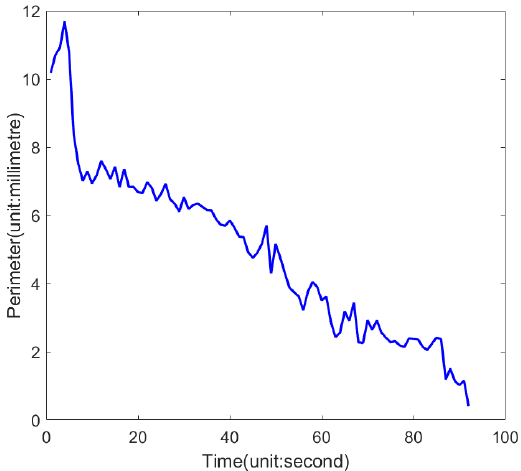
Figure 17. Variation of the perimeter of silicon dioxide at each moment during the melting process in the high-temperature cell.